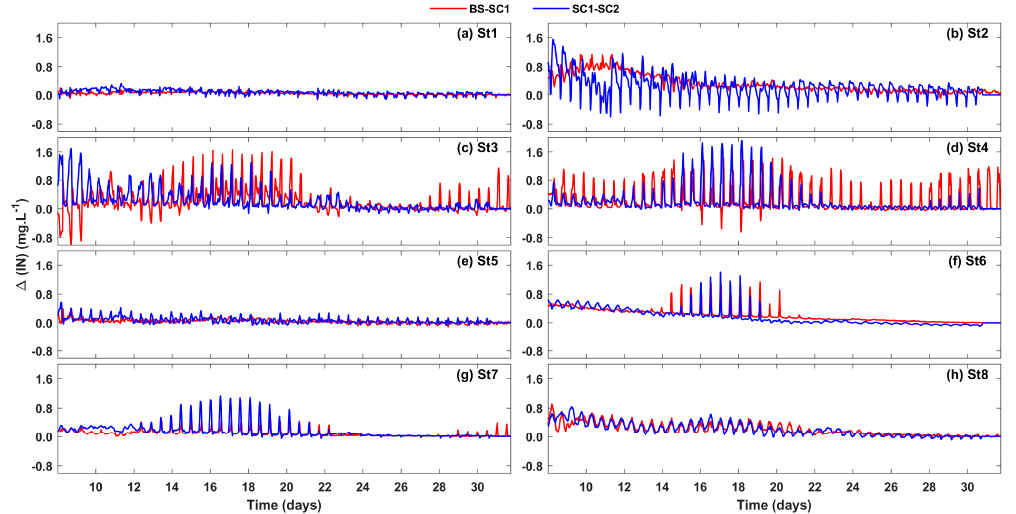
Figure 10. Time series of the inorganic nitrogen concentration di ff erence, ∆ (IN), between the scenarios (BS–SC1 and SC1–SC2), for September 2000, and the lagoon stations: ( a ) St1, ( b ) St2, ( c ) St3, ( d ) St4, ( e ) St5, ( f ) St6, ( g ) St7 and ( h ) Table 6. Inorganic nitrogen concentration difference, Δ( IN), metrics for BS–SC1 and SC1–SC2, and the lagoon stations (ST1–ST8).